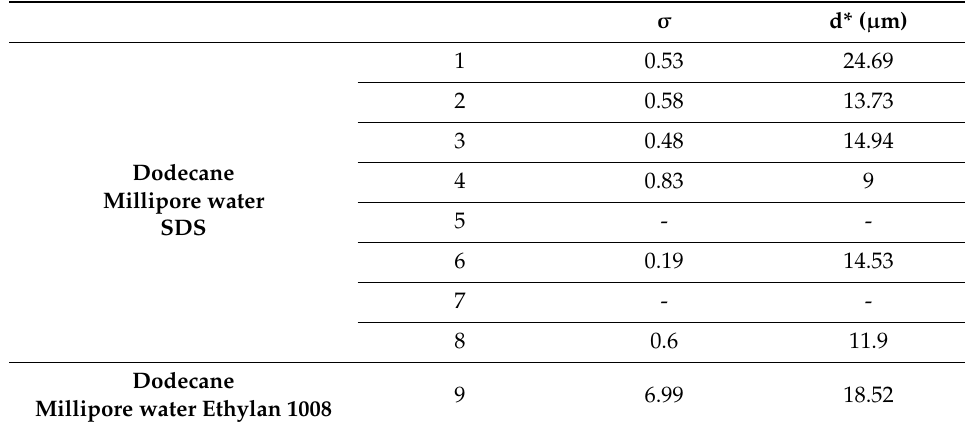
Table 5. Parameters of log-normal approximation of the experiments with Piston 1.